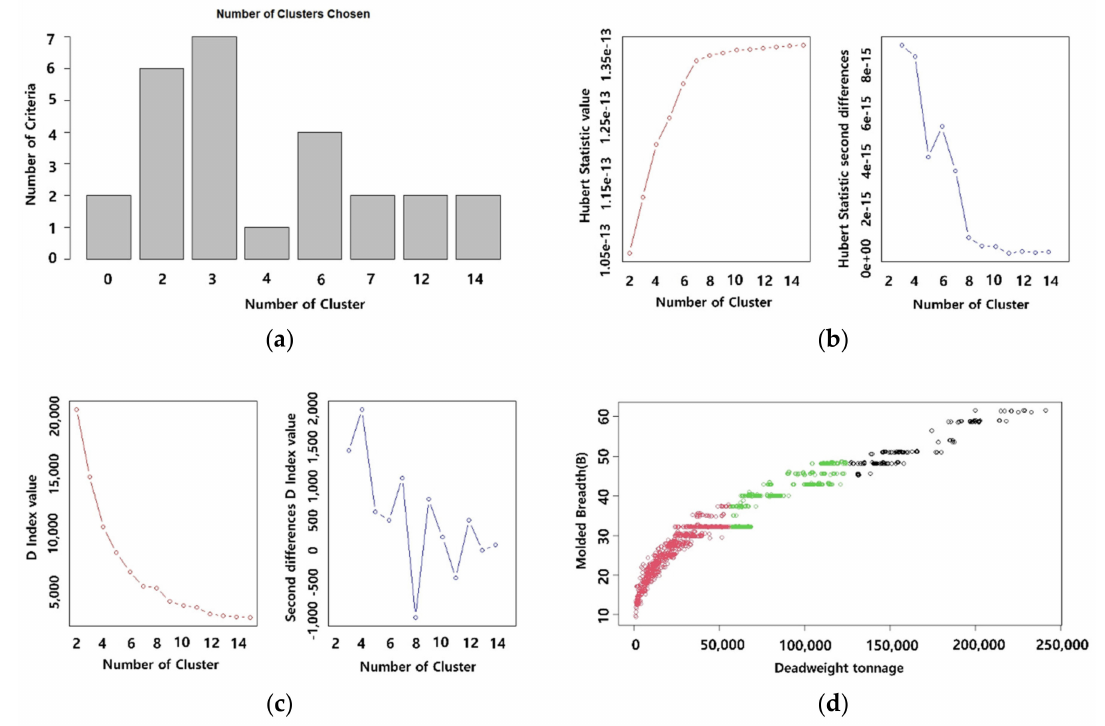
Figure 10. Results of k -means clustering on container ship deadweight tonnage–breadth (m). ( a ) Num- ber of clusters selected by NbClust; ( b ) Hubert statistic values; ( c ) D index value; ( d ) scatter plot clustered into three groups.